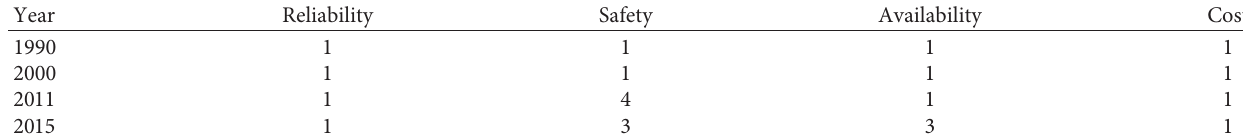
Table 8: Assessment of the bridge at the year of the last inspection.